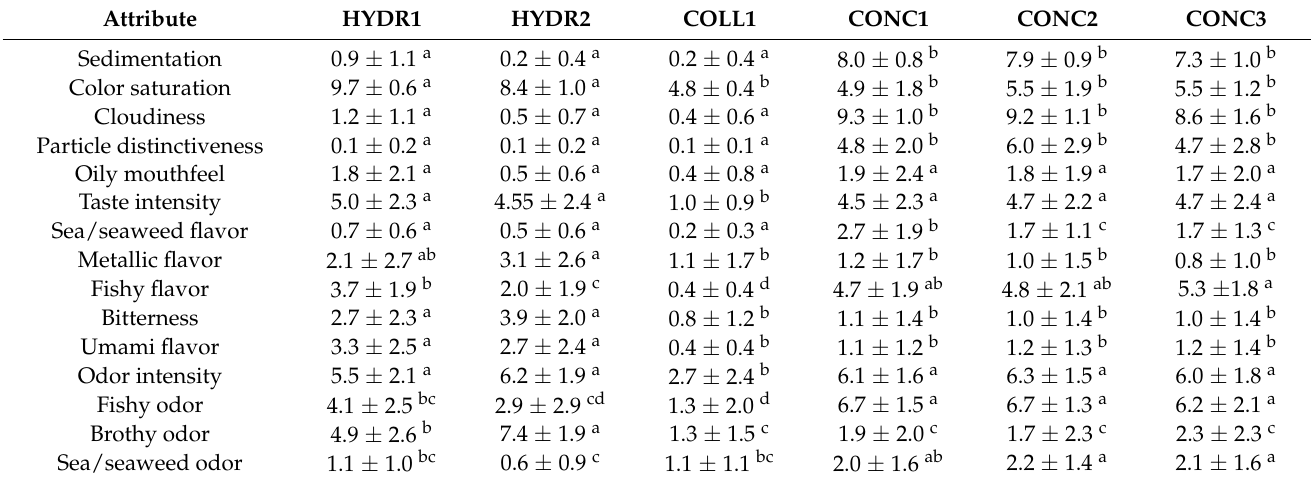
Fish protein concentrates = CONC1–3, fish protein hydrolysates = HYDR1–2, hydrolyzed fish collagen =